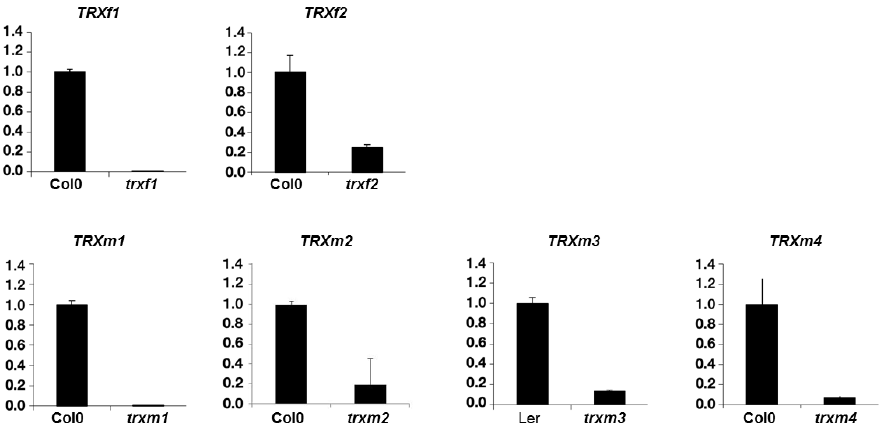
Figure 1. Thioredoxins ( TRXs) f and m transcript levels in trxf and trxm mutants.